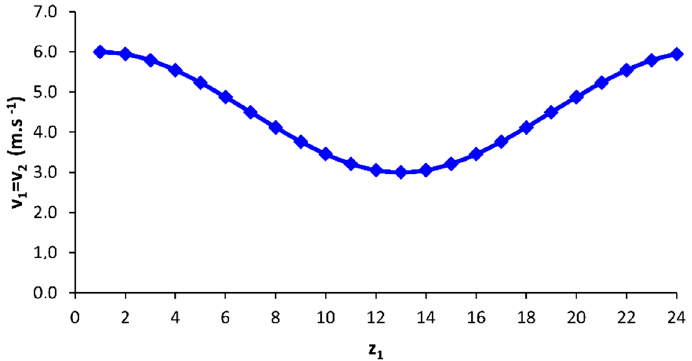
Figure 28. Circumferential velocities in the central point of mesh of teeth pairs.